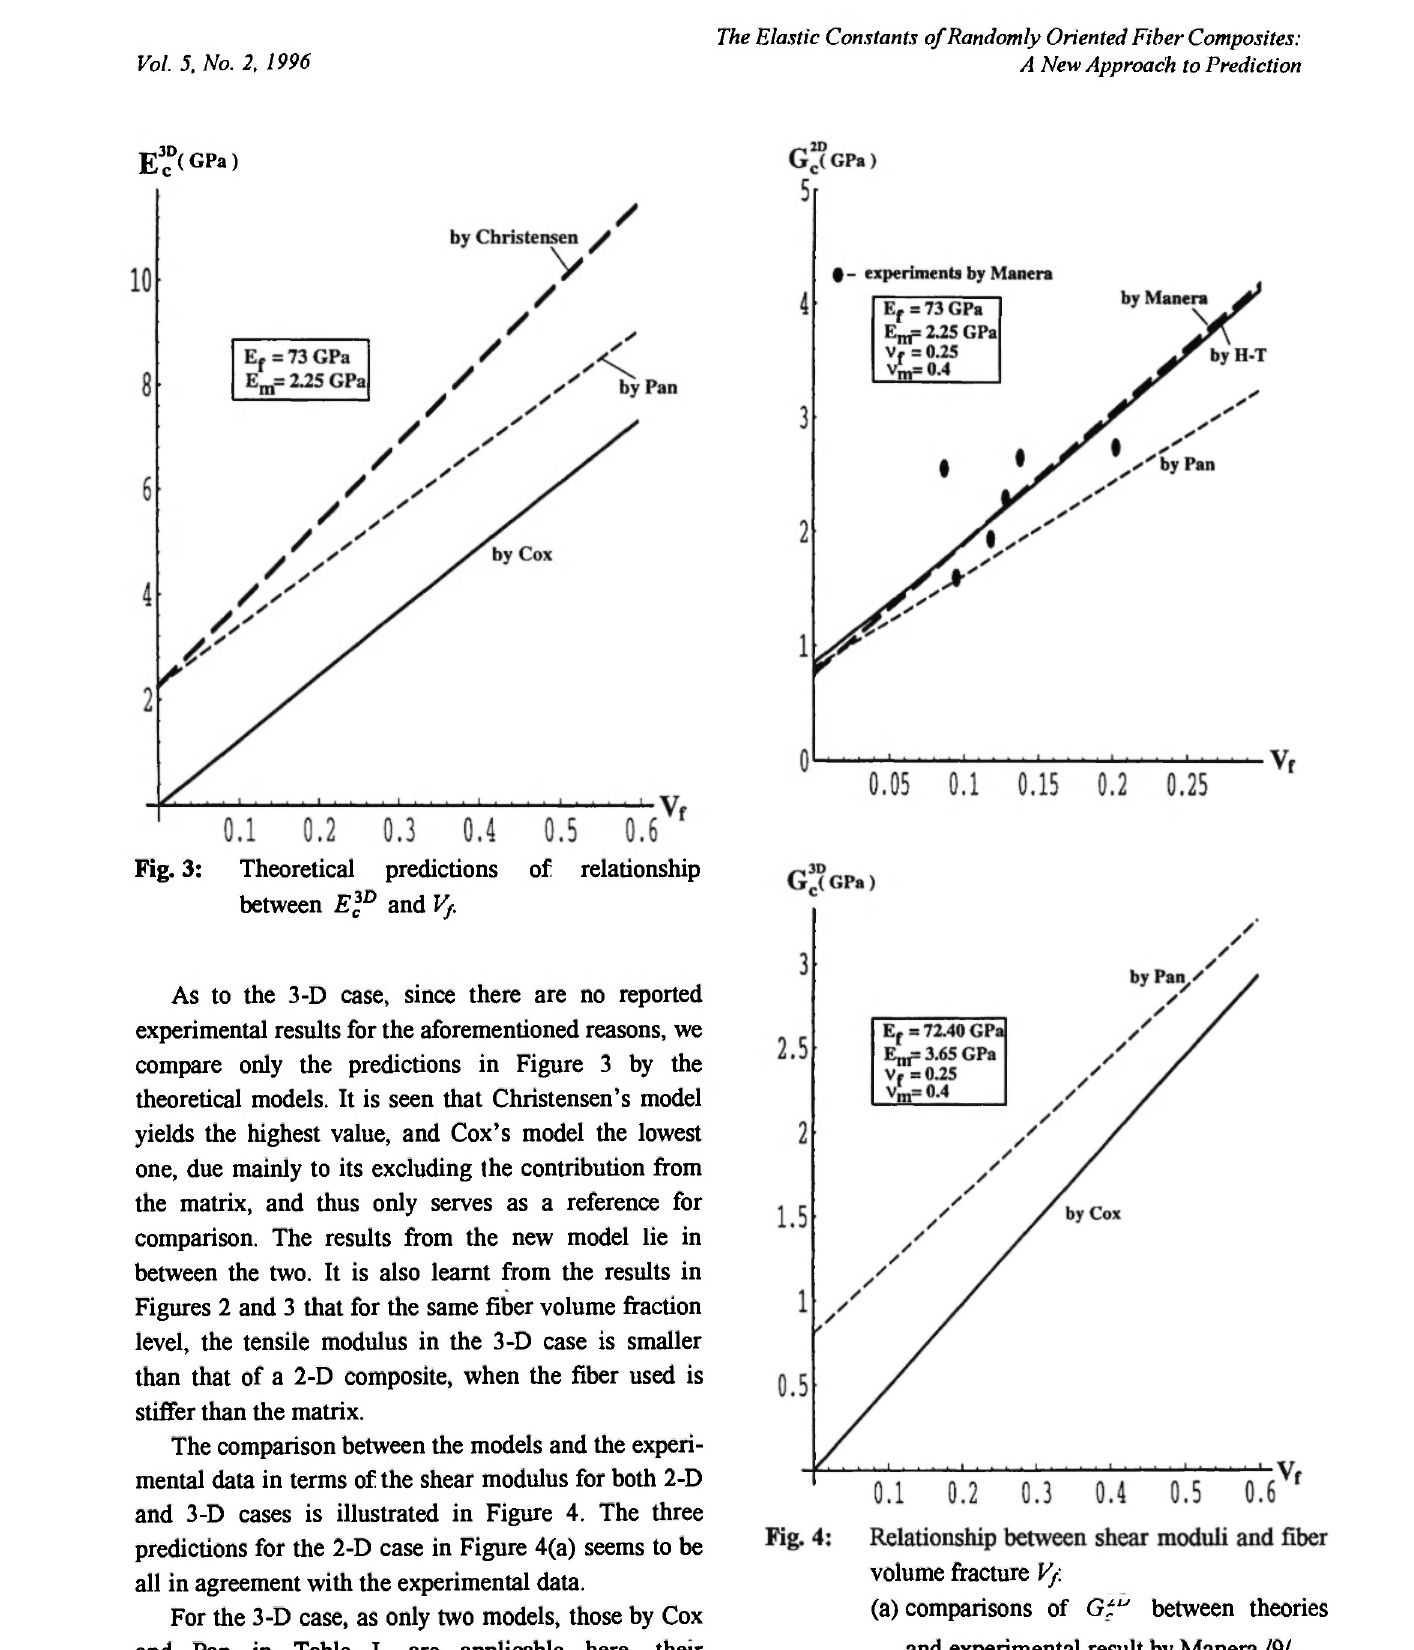
between theories and experimental result by Manera 191, (b) comparisons of Gl° between